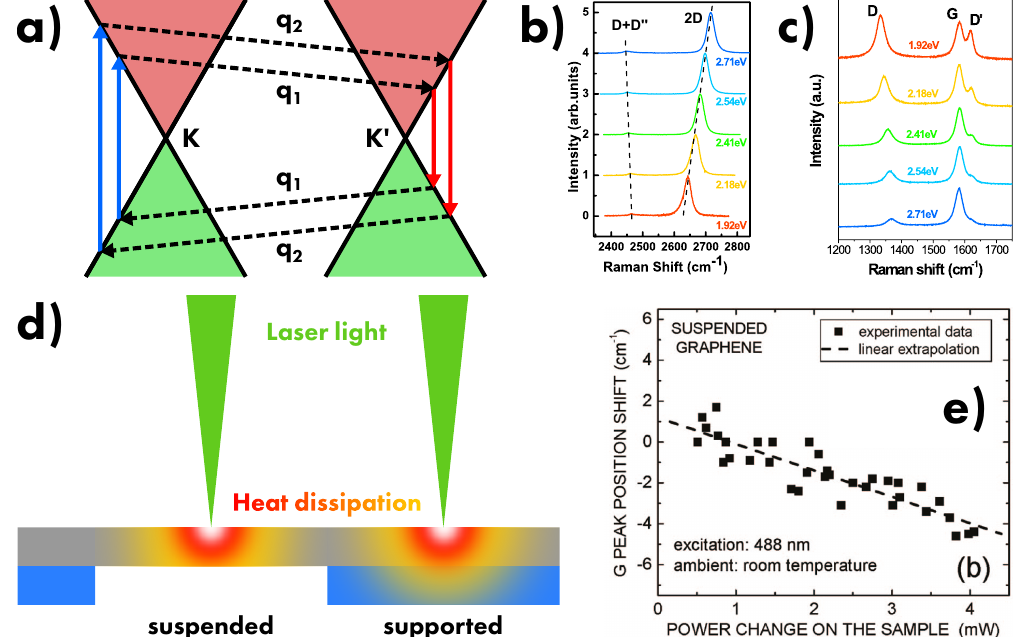
Figure 17. ( a ) Scheme of laser energy influence on scattering process for 2D mode ( b ) Peak position dispersion of D + D” and 2D bands for various laser energies. Reprinted with permission from Ref. [59]. Copyright (2007) American Physical Society. ( c ) Intensity change of G band for increasing laser energy, whereas the other resonant bands do not show any enhancement. Adapted with permission from Ref. [53]. Copyright (2017) Wiley. ( d ) Heat dissipation for suspended and supported graphene. ( e ) Shift of G peak position as effect of laser power. Reprinted with permission from Ref. [61]. Copyright (2008) American Chemical